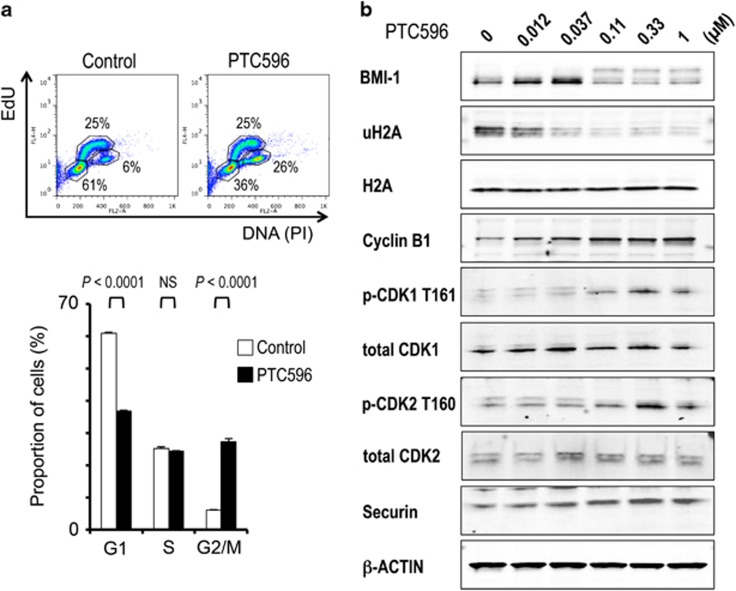
PTC596 causes mitotic arrest in AML cells. (a) MOLM-13 cells were exposed to 200 nM PTC596 for 10 h and cell cycle progression was determined. The dot plot represents EdU incorporation (y axis) versus DNA content, as determined by PI staining (x axis). The results are expressed as the mean±s.d. of triplicate measurements. NS, not significant. (b) Expression of BMI-1, ubiquitinated histone H2A (uH2A), H2A and G2/M cell cycle regulator proteins in MOLM-13 cells treated with the indicated concentrations of PTC596 for 20 h.